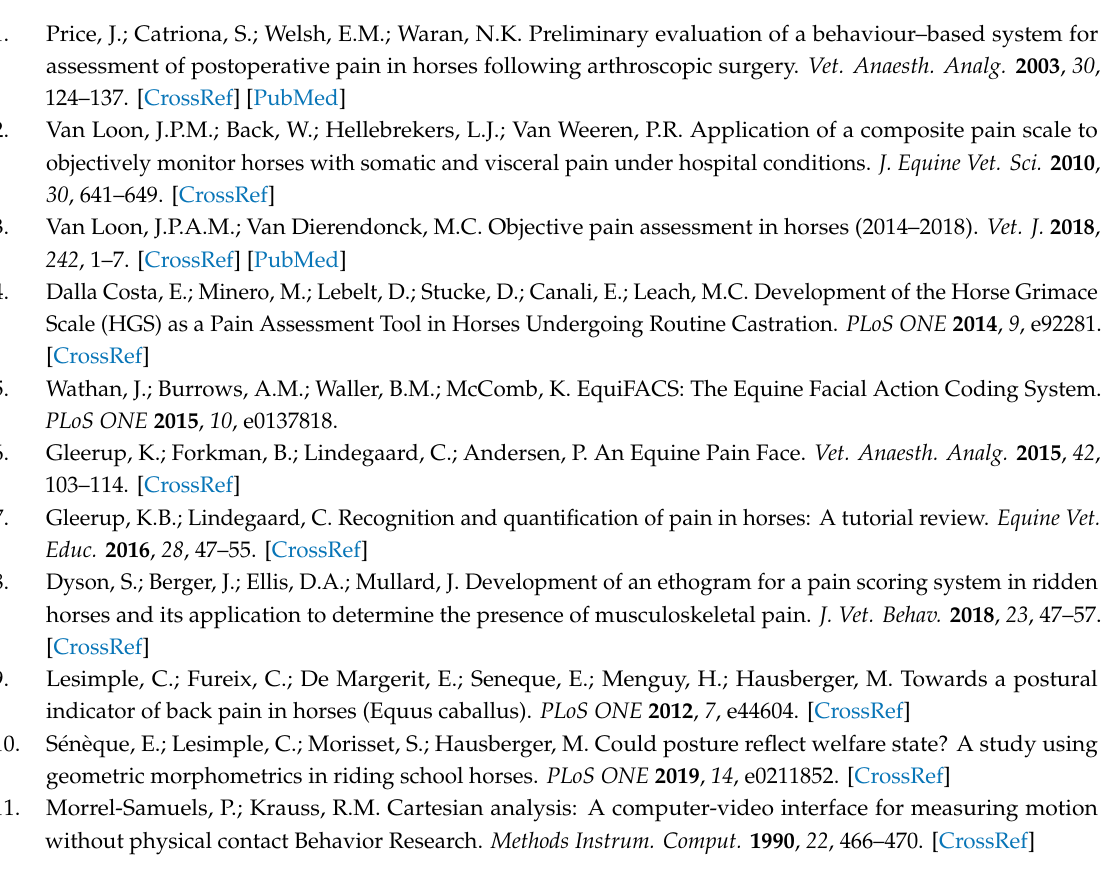
Table S1: Detailed results of the counting first and last 1000 images per horse video. TN = true negative, TP = true positive, FN = false negative, FP = false